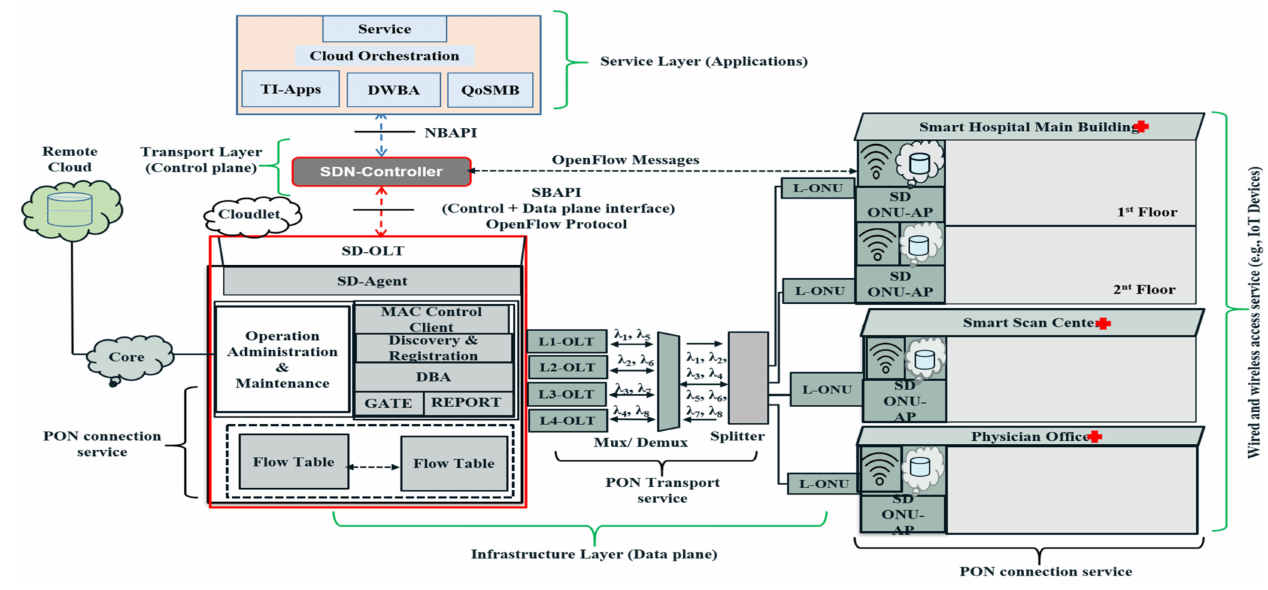
Figure 2. Smart hospital cloudlet-based TI-SDOAN network communication